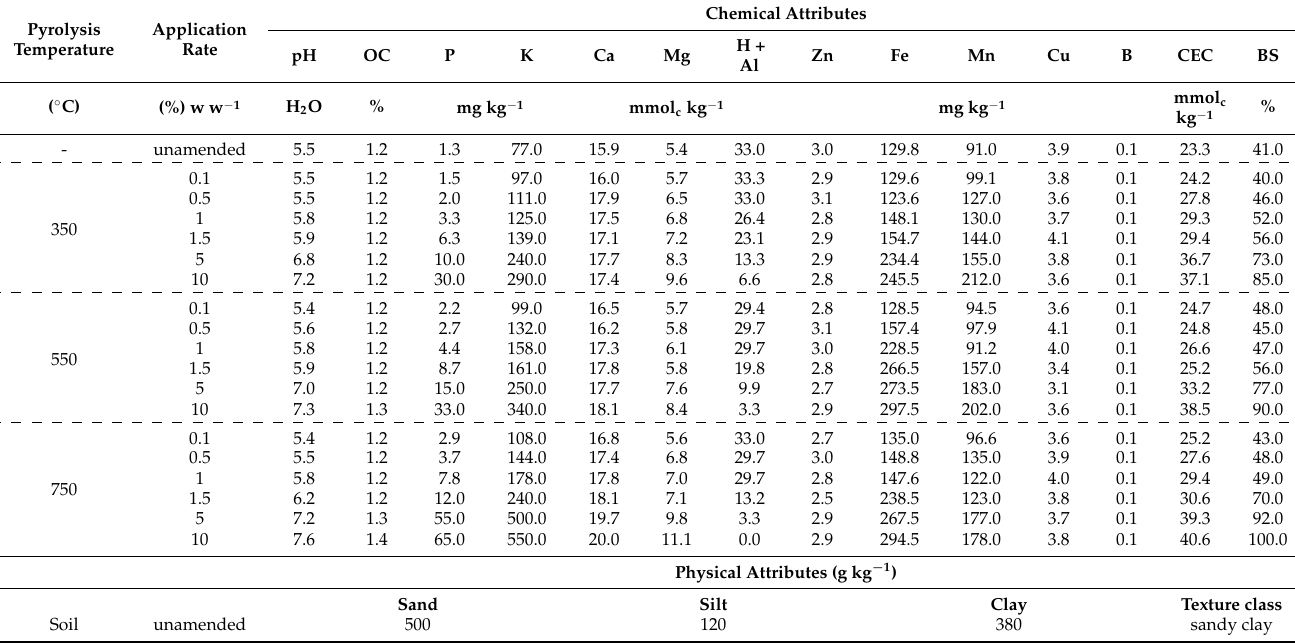
Table 2. Physicochemical attributes of the soil amended with sugarcane straw biochar and una- mended soil used in this